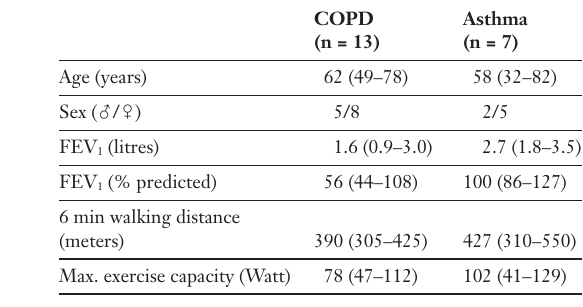
Baseline characteristics of patients at study entry. Values are given as mean (range).